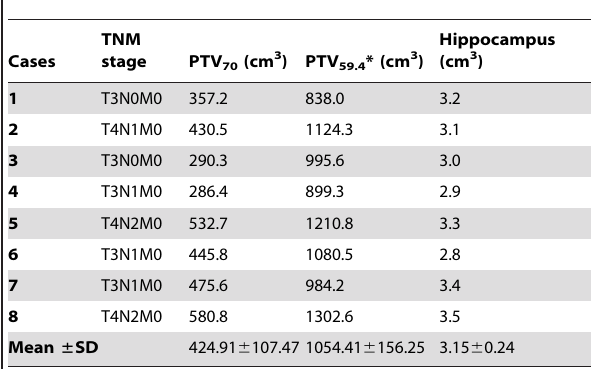
Table 1. Tumor stage, PTV and hippocampus volumes. Table 2. PTV dosimetric parameters with and without HP